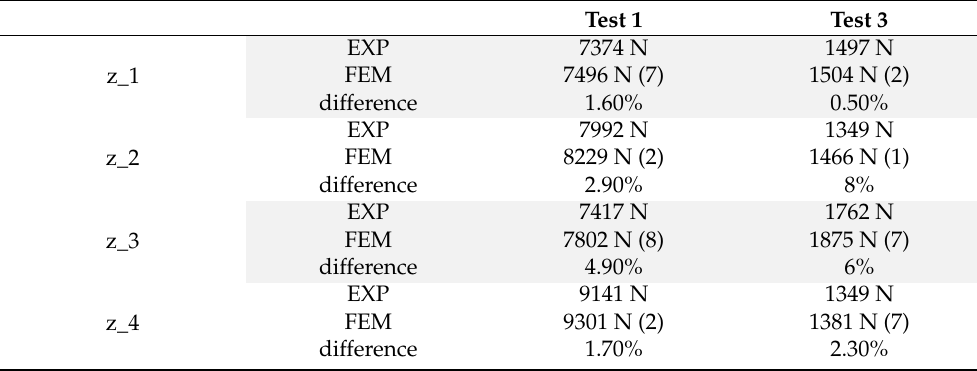
Table 4. The failure-initiation force value for composite